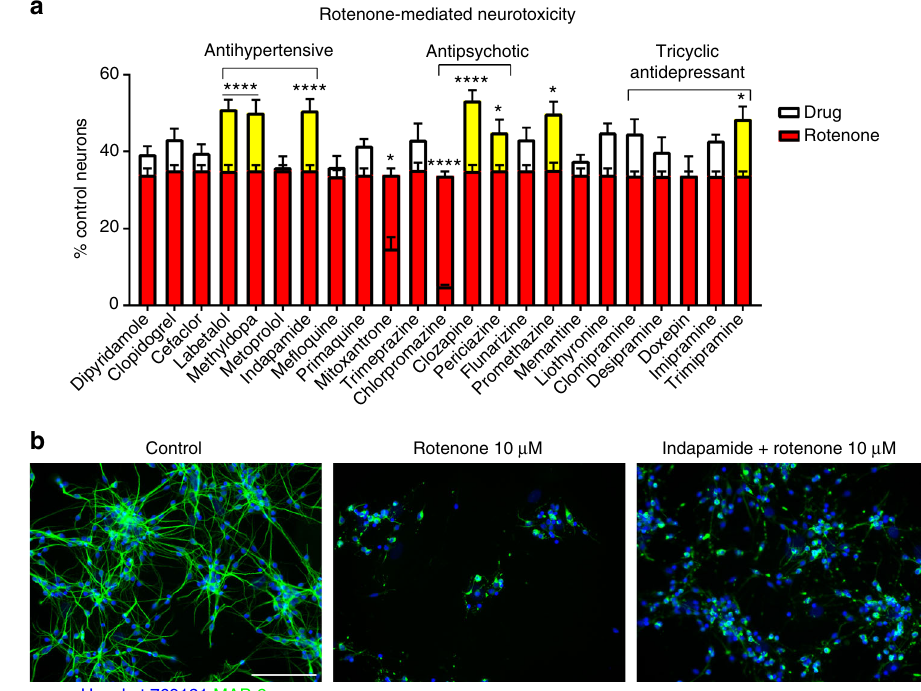
Fig. 3 Prevention of mitochondrial damage induced by rotenone. Some of the generic drugs that prevented against iron-mediated neurotoxicity were tested against mitochondrial damage to neurons. Some compounds, such as indapamide, prevented mitochondrial damage as shown after normalization to the control neurons ( a ). However, the rescue effect was small. Treatment with rotenone induced marked morphological changes with retraction of cell processes ( b ). The scale bar shows 100 µ M. Shown are normalized data of mean ± SEM of 1 – 3 experiments each performed in quadruplicates. Two-way ANOVA with Bonferroni multiple comparisons test as post hoc analysis vs. rotenone: * p < 0.05; **** p <